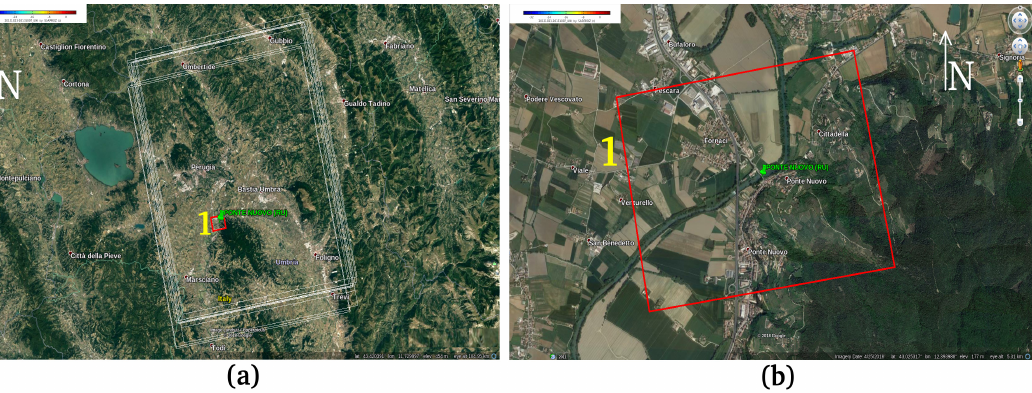
Figure 6. Case study 2 optical representations. ( a ): georeferenced footprints of the SAR long temporal series. ( b ): ROI